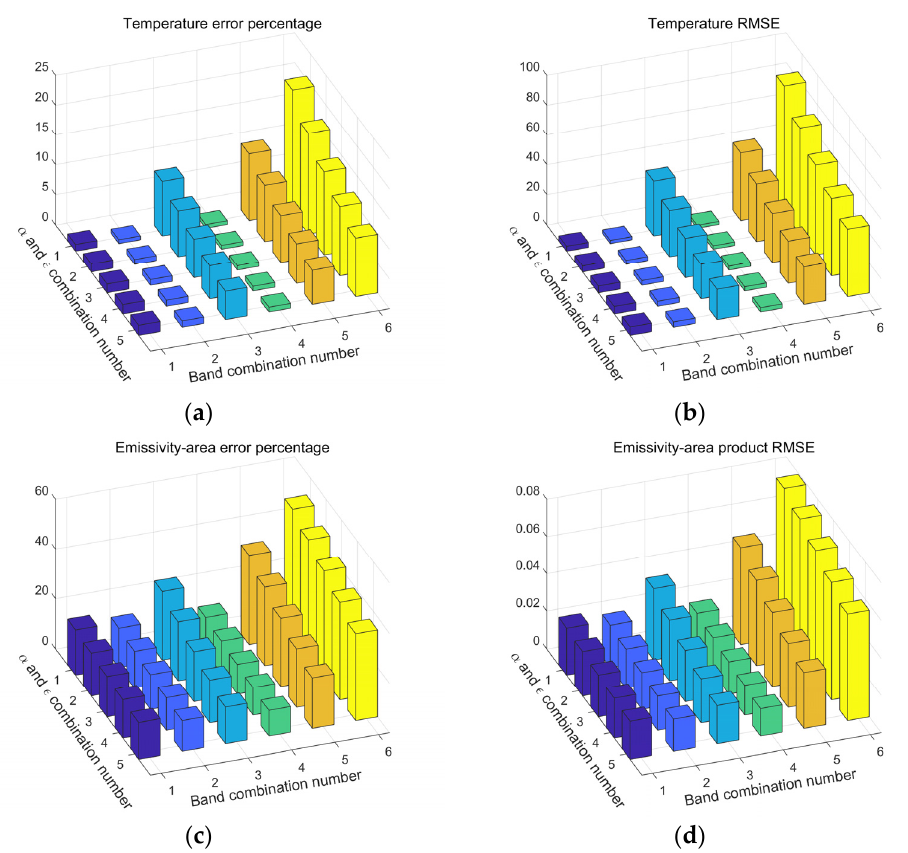
Table 2. The absorptivity and emissivity (=0.5) combination number.